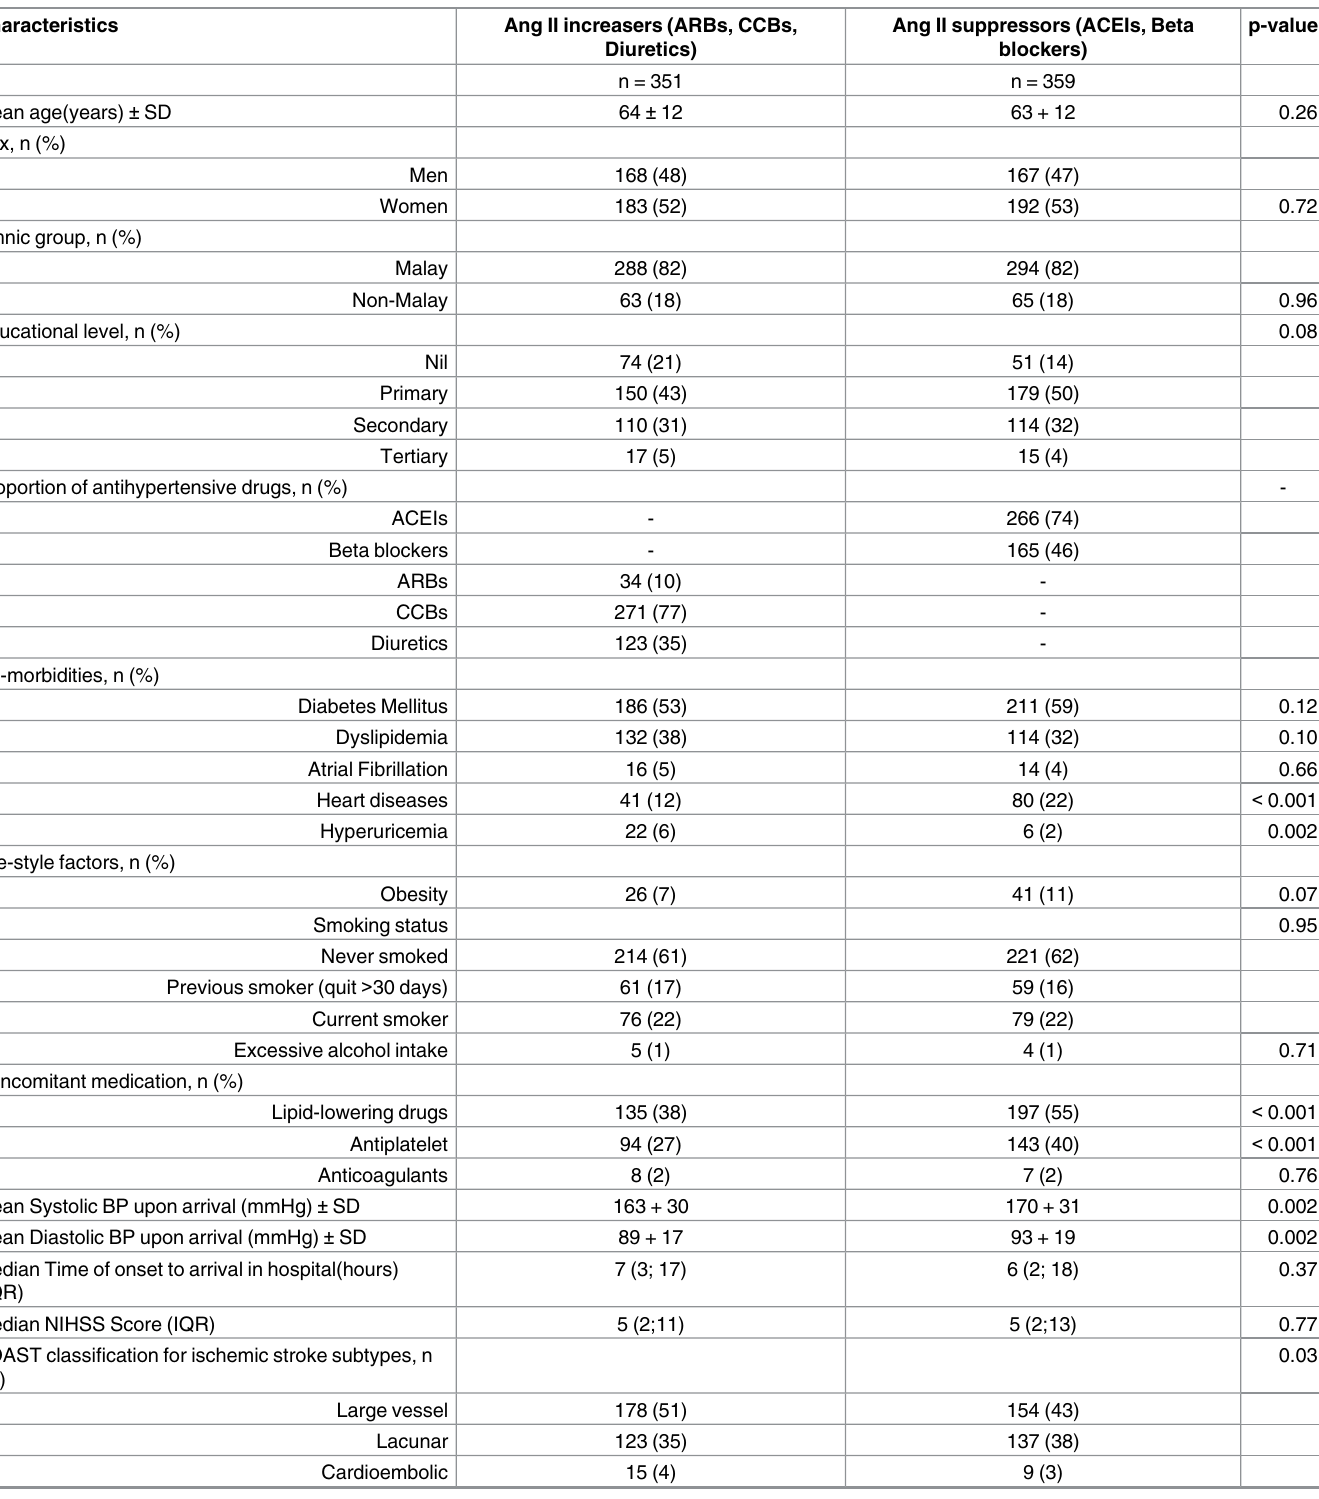
Table 1. Baseline Characteristics by Types of Antihypertensive Drugs. *